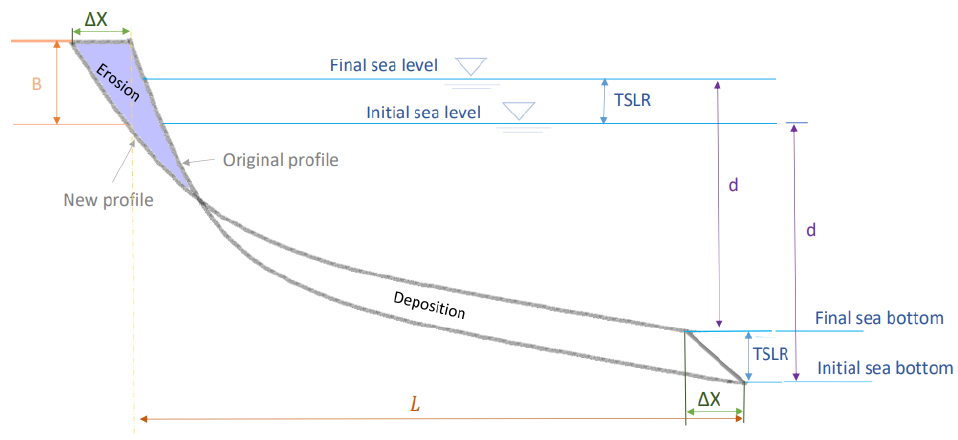
Figure 2 . Bruun Rule variables. Figure 2. Bruun Rule